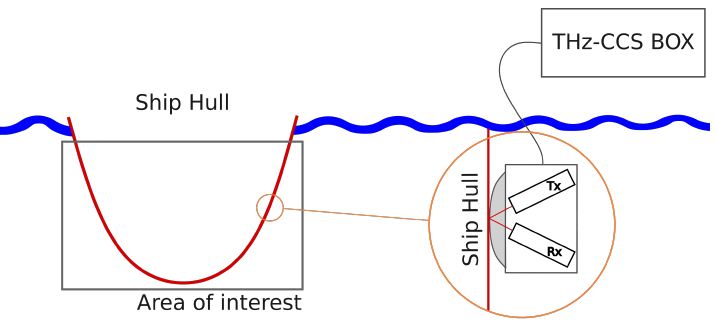
Figure 1. Outline of a potential solution, showing the area of interest on the hull, the underwater part of the prototype containing the THz antennae with a silicone contact patch, and the box containing other necessary components of the THz-CCS system above